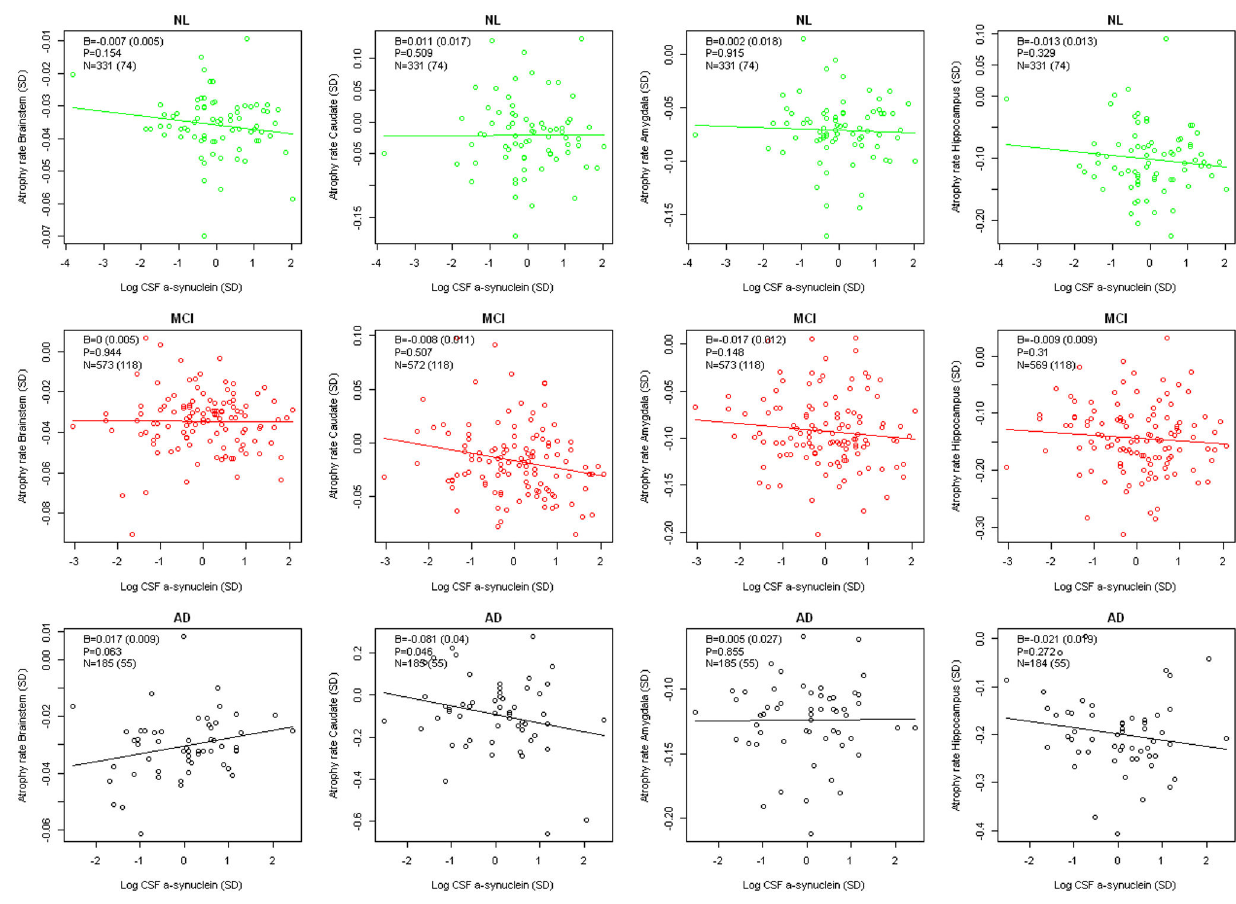
Figure 2. Longitudinal volume changes in relation to baseline CSF α-synuclein in a priori defined regions. Data for the a priori defined regions of interest in NL (top row), MCI (middle row), and AD (bottom row). Y-axes show atrophy rates in individual subjects, calculated by linear mixed effects models, adjusted for age, APOE and sex. X-axes show baseline CSF α-synuclein levels. Regression lines for CSF α-synuclein linearly regressed on adjusted atrophy rates. In each panel, β-coefficients (standard errors in brackets), p-values (not corrected for multiple comparisons), and number of observations (number of subjects in brackets) are from the interaction CSF α-synuclein:time in the linear mixed effects model: volume ~ CSF α-synuclein:time + age + APOE + sex. No p- values were significant after correction for multiple comparisons by a false discovery rate correction (correcting within study group [4